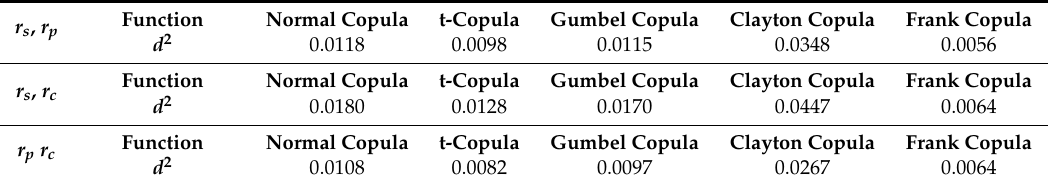
Table 4. Squared Euclidean distances d 2 .